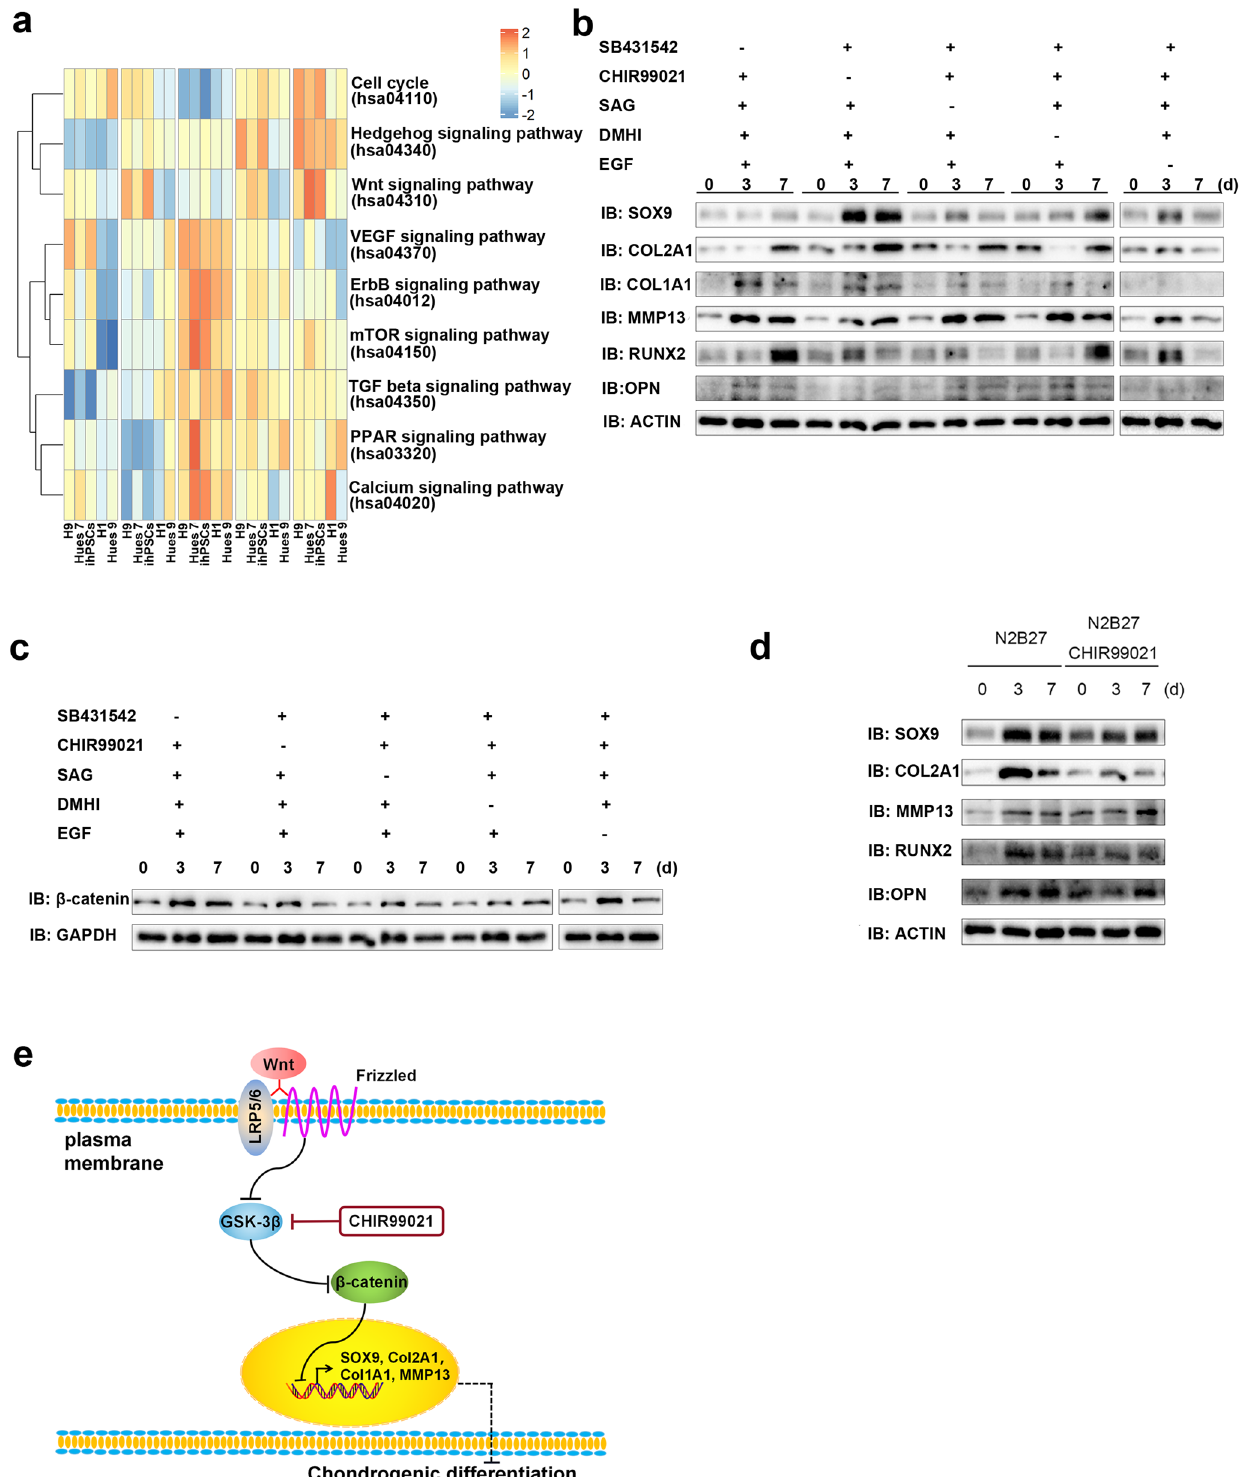
Fig. 7 The activated Wnt signalling pathway affects chondrogenic differentiation of ECCs. a KEGG analysis of bulk RNA-seq at different induction points. b The transcription factor SOX9, condylar chondrocyte anabolism markers COL2A1 and COL1A1, and the catabolism marker MMP13 were obviously upregulated 3 days after the removal of CHIR99021. c An obvious downregulation of β -catenin was detected by western blotting 7 days after the removal of CHIR99021. d The chondrogenic transcription factors SOX9 and RUNX2 were decreased, as well as COL2A1 and OPN, while MMP13 was enhanced in the presence of CHIR99021 in N2B27. e A scheme for the Wnt signalling pathway involved in chondrogenic differentiation of